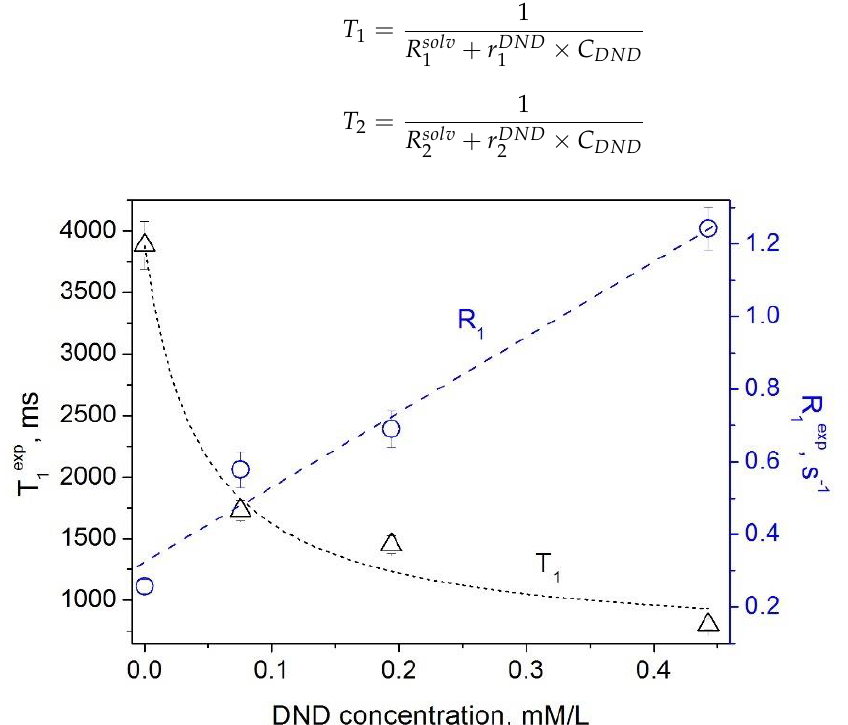
Figure 1. Dependence of the spin–lattice relaxation rate R 1 (circles) [16] and the spin–lattice relaxation time T 1 (triangles) of water protons in aqueous DND suspensions on the DND concentration.